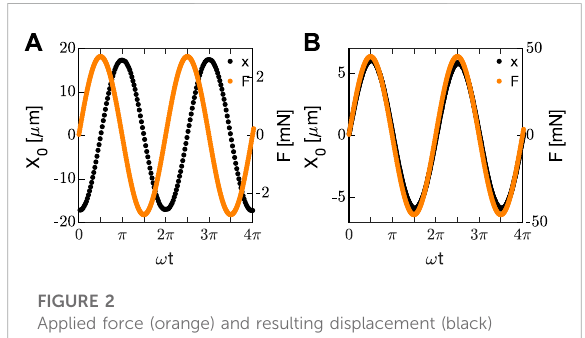
FIGURE 2 Applied force (orange) and resulting displacement (black) obtained measuring silicon oil at ω = 2.46 rad/s (A) and Sylgard at ω = 0.1 rad/s (B)